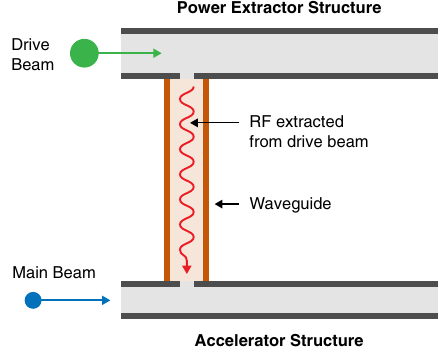
FIG. 1. Schematic of two-beam structure-based wakefield acceleration. Rf power is generated from a drive beam (green) by the power extractor structure. This rf pulse is transported through a waveguide to a separate accelerator structure, where the main beam (blue) is